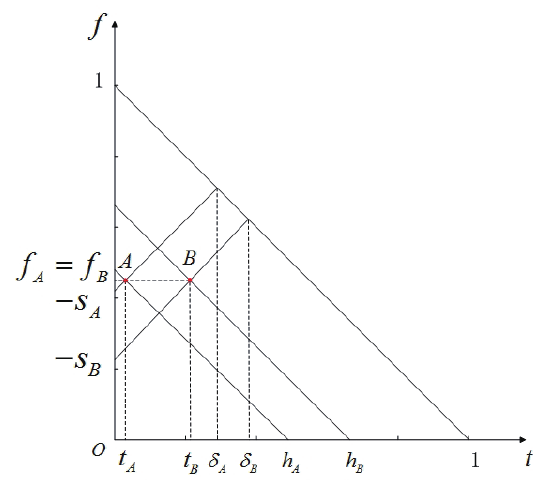
Figure 3. The equivalence of the orders ≤ ( f , t ) , ≤ ( f , s ) , ≤ ( f , h ) and ≤ ( f , δ )